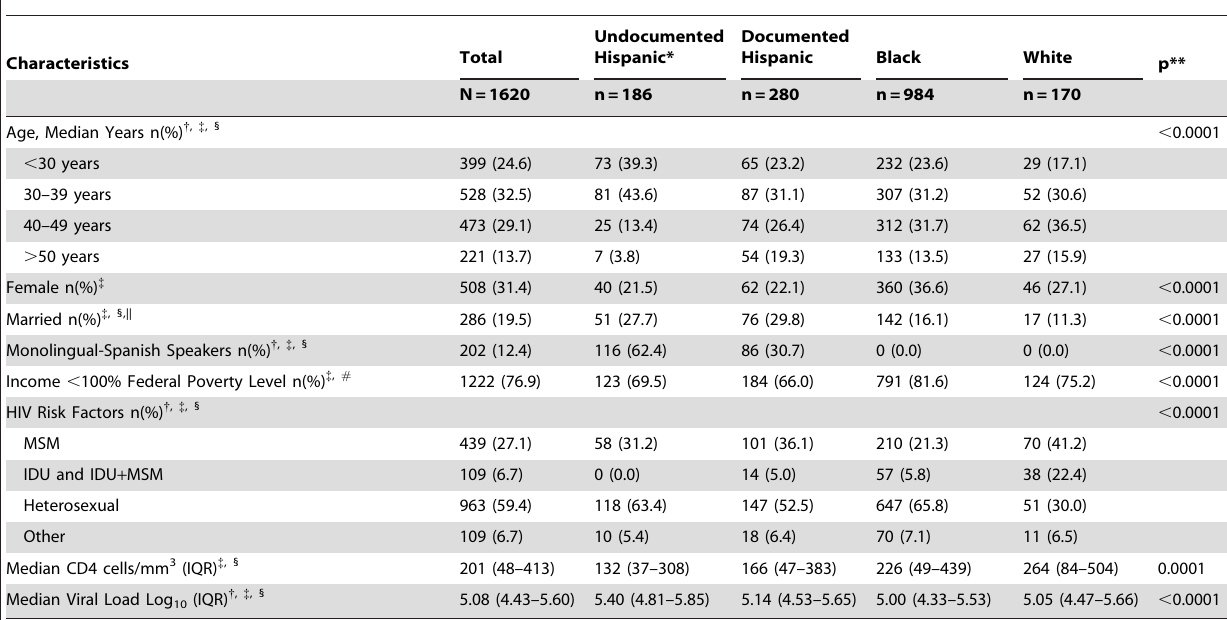
Table 1. Baseline characteristics of persons initiating care at Thomas Street Health Center in Houston, Texas.